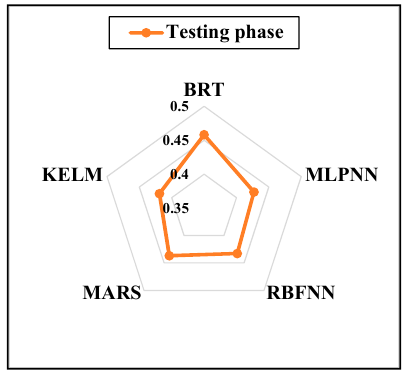
Figure 4. Comparison of root mean square error ( RMSE ) values for the best composite models during the testing phase (Durham station).